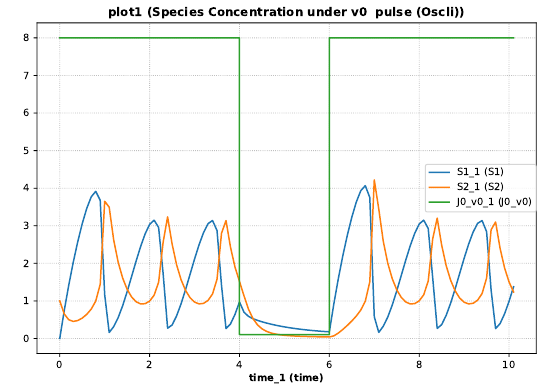
Figure A.9: The simulation result from the simulation description given in List- ing A.6. Simulation with SED-ML web tools [2].